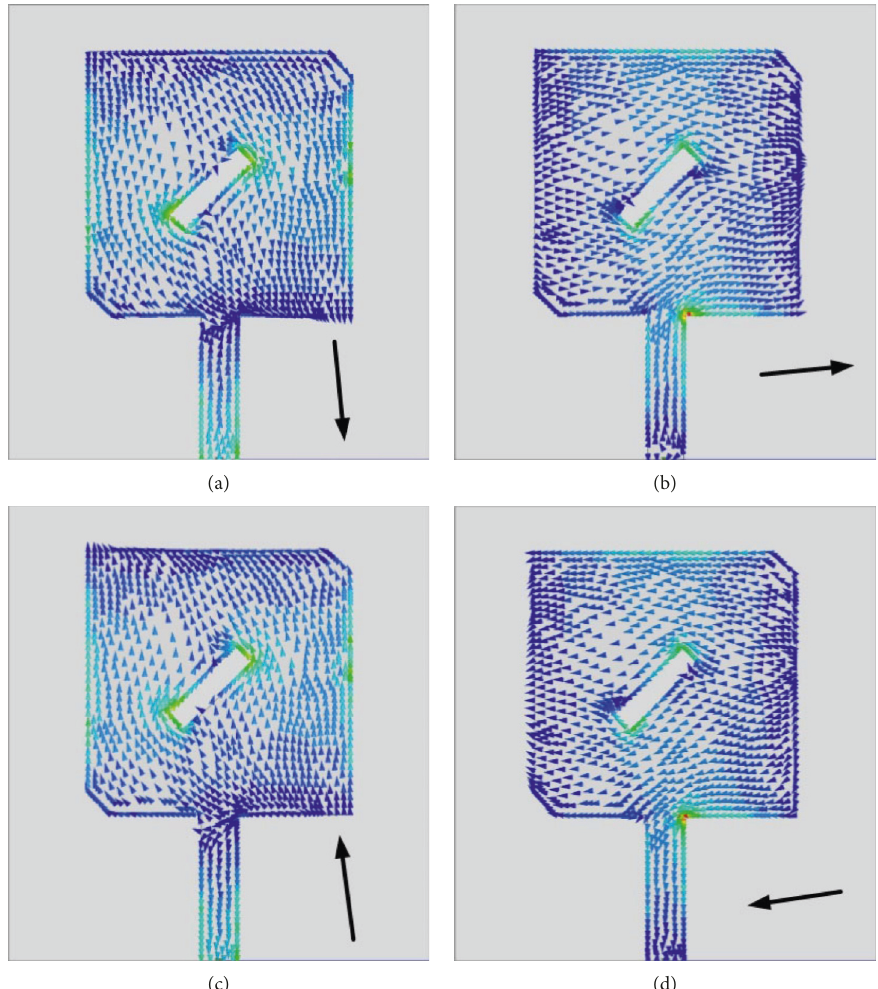
Figure 5: Distributions of the surface current on the proposed antenna at 2.45GHz with different phase angles: (a) 0 ° , (b) 90 ° , (c) 180 ° , and (d) 270 °